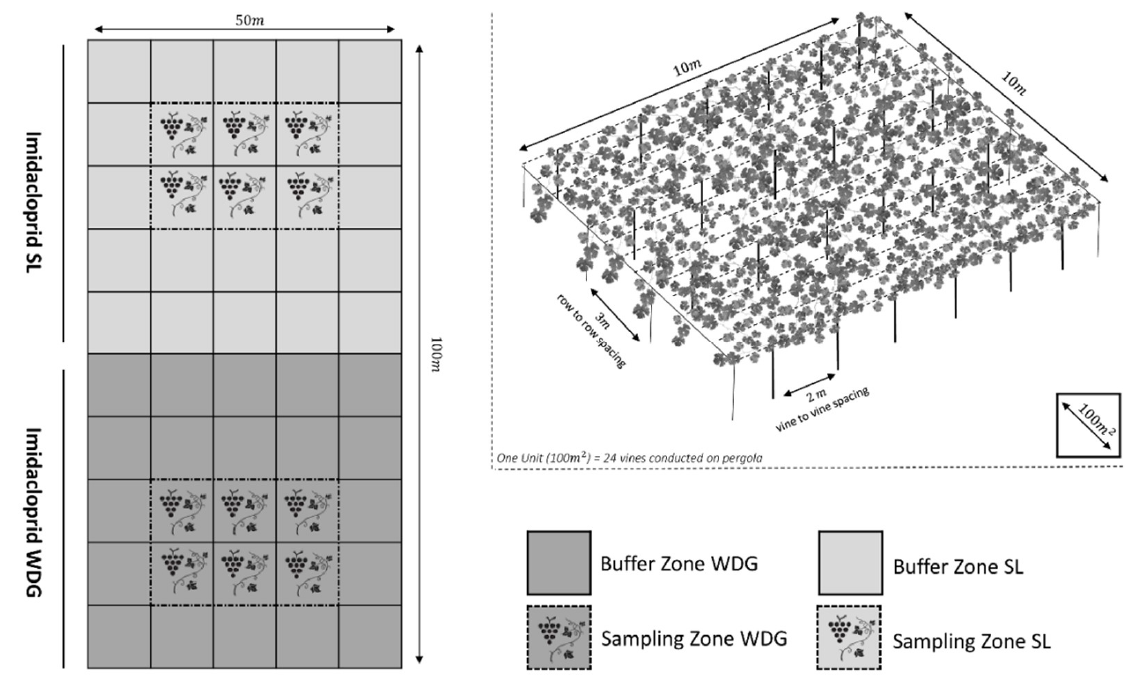
Figure 2. On the left: layout of the field experimental design showing the surface area treated with imidacloprid SL (light grey), the surface area treated with imidacloprid WDG (dark grey), buffer zones and sampling zones. On the top right: an overview of vines conduction system (pergola) and canopy density per unit.